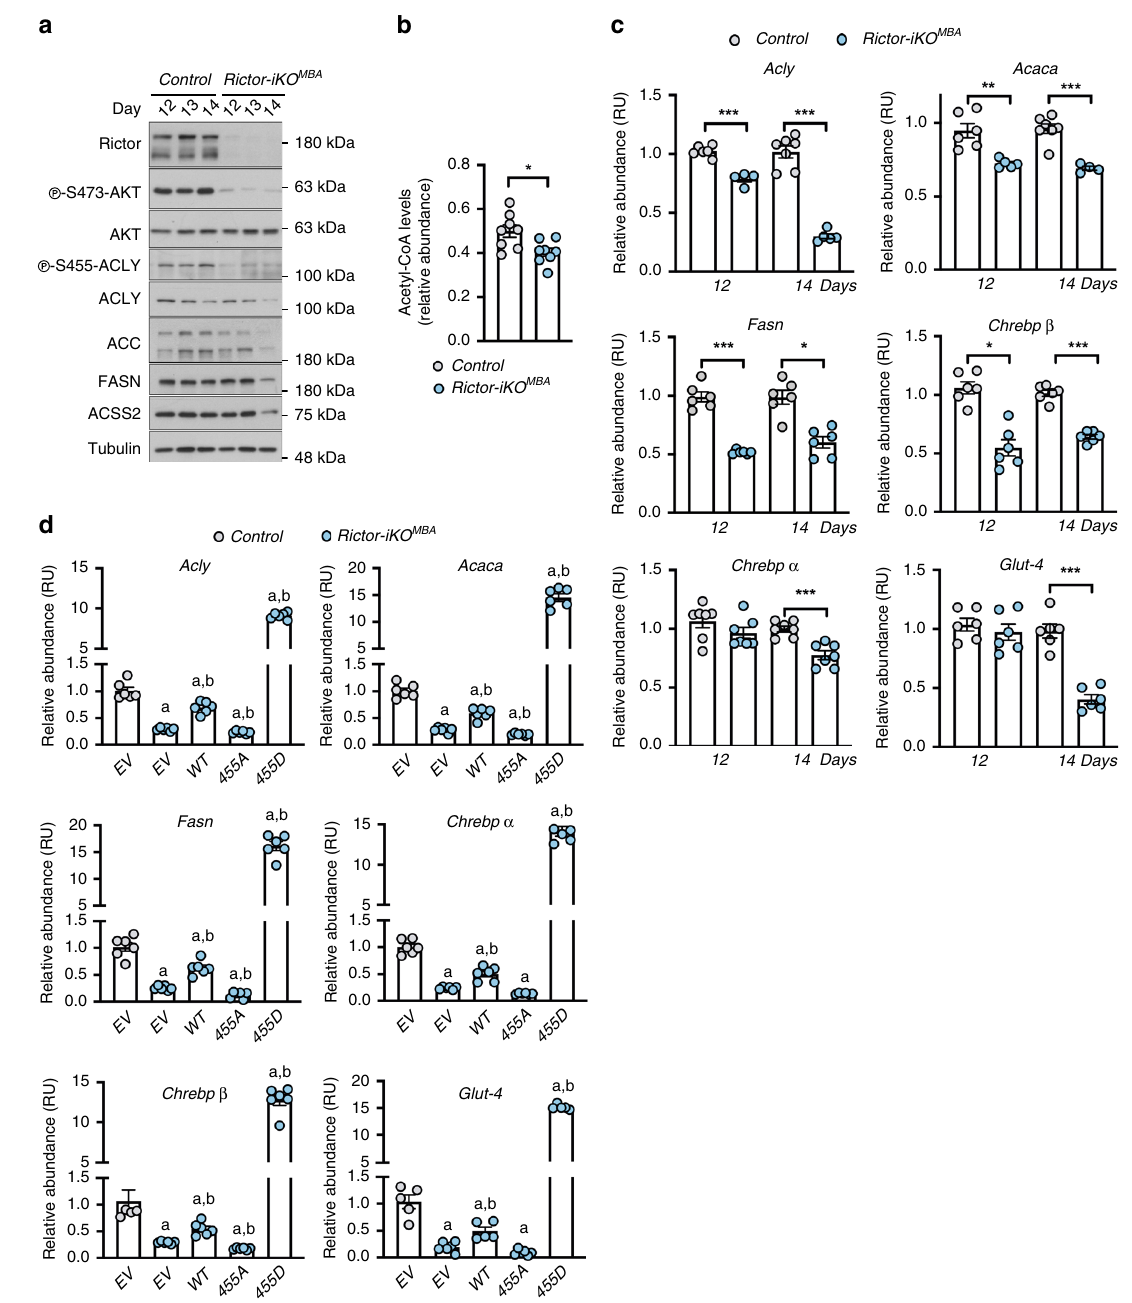
Fig. 6 mTORC2 drives lipogenic and Glut4 gene expression through ACLY in mature brown adipocytes. a Time-course western blots showing the indicated phospho-speci fi c and total proteins in Rictor-iKO MBA or Acly-iKO MBA cells following acute and prolonged protein loss. b Direct acetyl-CoA measurements in Rictor-iKO MBA cells following acute Rictor loss (day 12) ( n = 8 per group). c qRT-PCR analysis of the indicated genes following acute (day 12) and prolonged (day 14) Rictor loss ( n = 6 per group). Rictor deletion was induced at day 8 during differentiation. d qRT-PCR analysis of the indicated genes Rictor-iKO MBA ( n = 6 per group) stably expressing empty (EV), Myc-ACLY-WT, Myc-ACLY-S455A, or Myc-ACLY-455D constructs. Bar graphs represent mean ± SEM. * p < 0.05, ** p < 0.01, *** p < 0.001, a represents *** p < 0.001 vs control (EV), and b represents *** p < 0.001 vs Rictor-iKO MBA (EV) cells. Statistical signi fi cance was calculated by using two - tailed unpaired Student ’ s t test ( b ) or two-way ANOVA with Sidak ’ s test multiple comparisons ( c , d